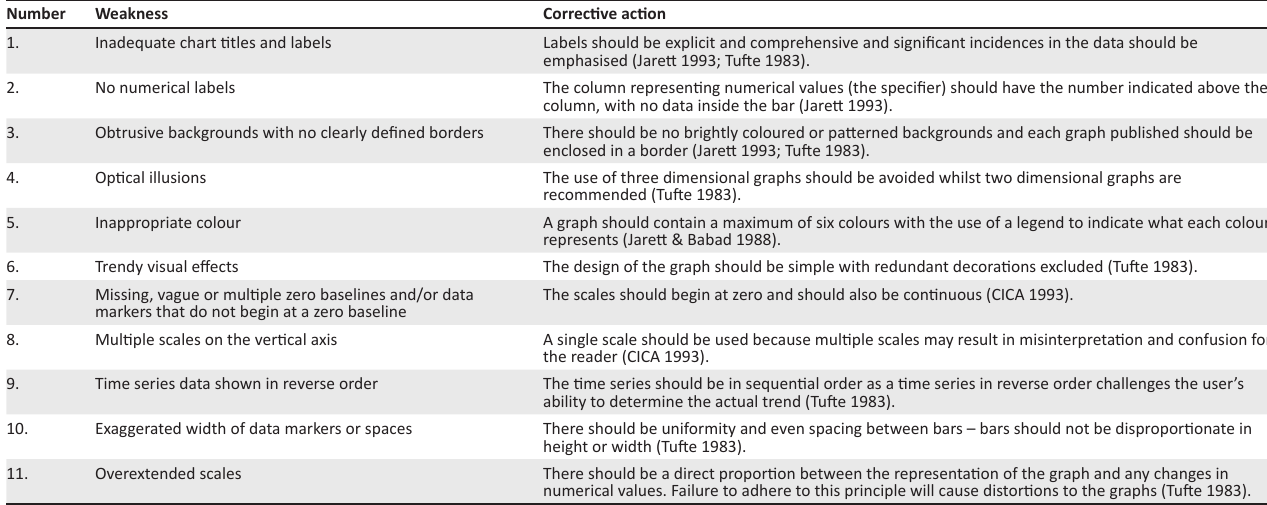
TABLE 1: Weaknesses and corrective actions relating to